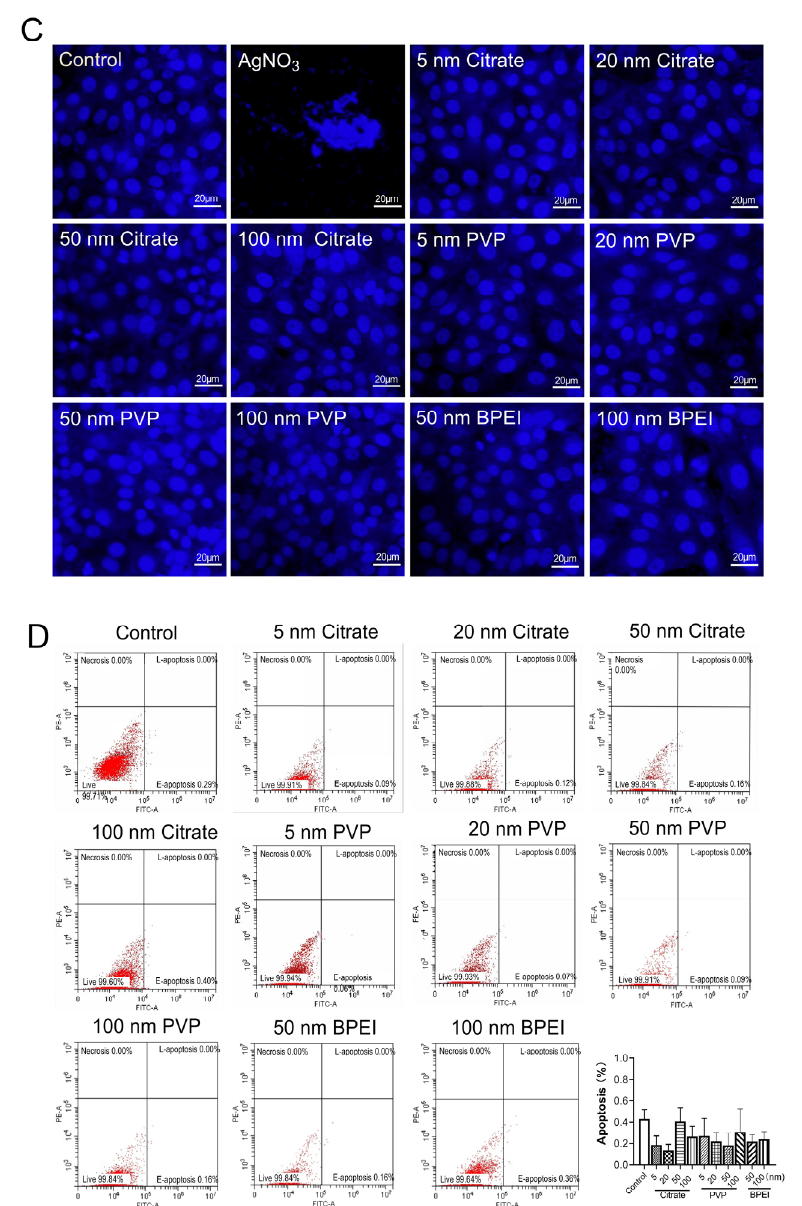
Figure 5. Evaluation of the cytotoxicity of AgNPs. ( A ) CCK-8 assays showing the effect of AgNO3 on the viability of Vero E6 cells (n = 8 groups); ( B ) Crystal violet staining of Vero E6 cells treated with AgNO3, citrate, PVP, and BPEI coated AgNPs, with different particle sizes; ( C ) Hoechst staining showing the effects of AgNO 3 , citrate, PVP, and BPEI coated AgNPs, with different particle sizes on the cell nucleus of Vero E6 cells, scale bar = 20 µ m; ( D ) effects of citrate, PVP, and BPEI coated AgNPs on the apoptosis rate of Vero E6 cells, *** p <